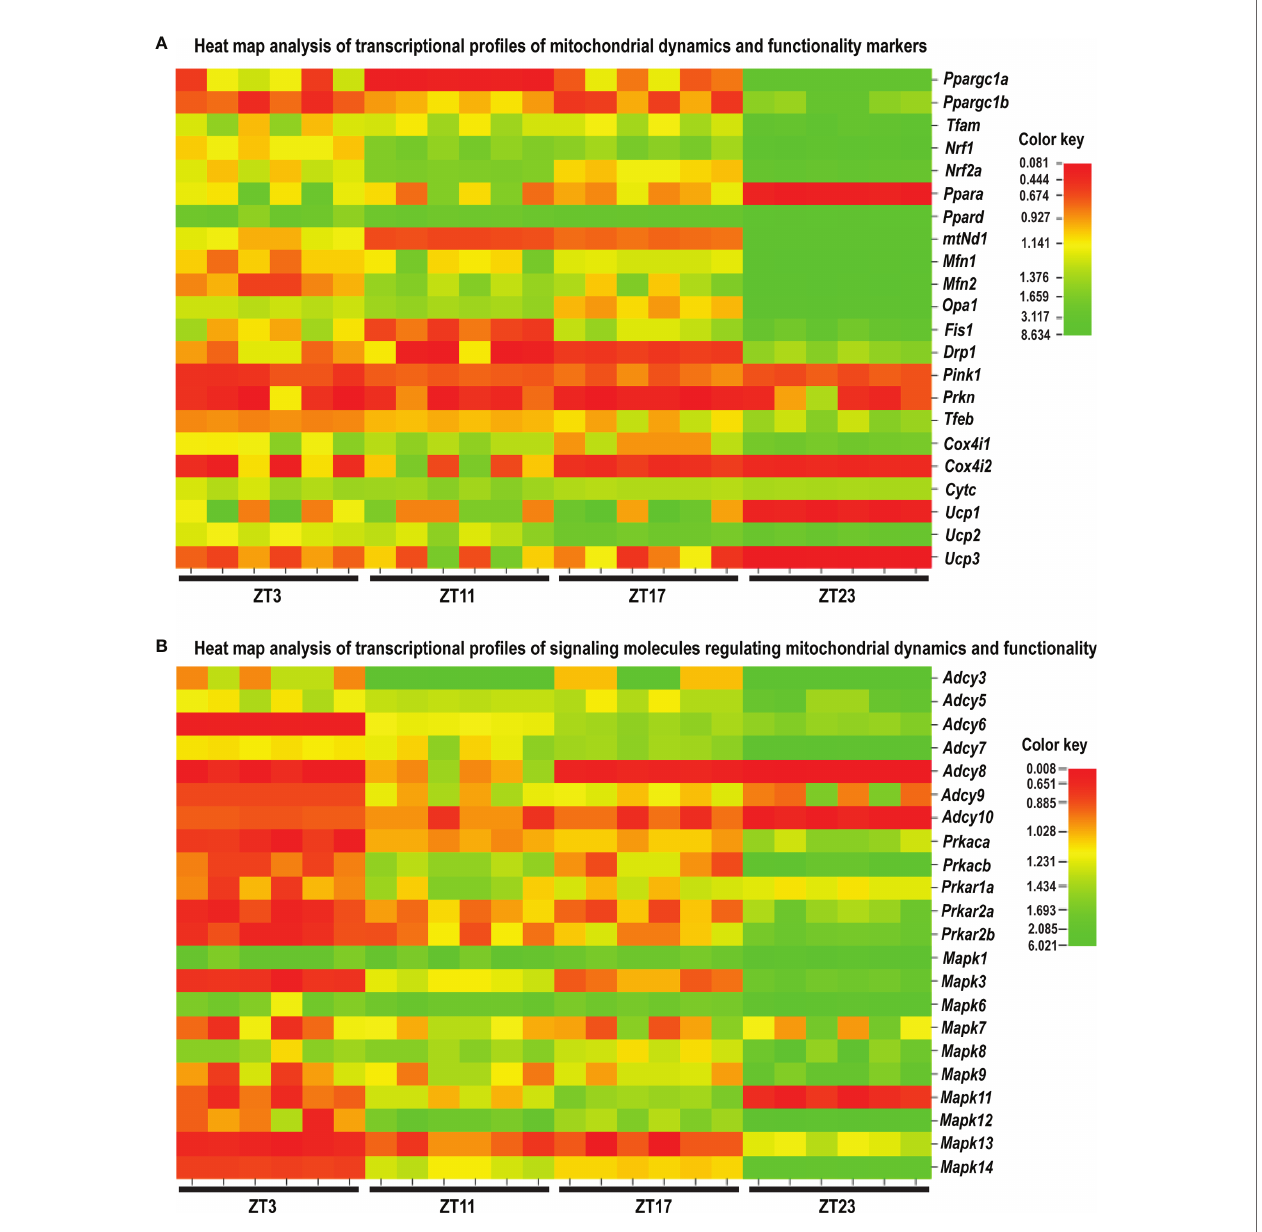
FIGURE 10 | Heat map analysis of the transcriptional pro fi le of the mitochondrial dynamic and functionality markers (A) and the signaling molecules regulating mitochondrial dynamics and functionality (B) in spermatozoa of acute stressed adult rats. Heat map analysis showing different patterns of transcription at different time points in spermatozoa after the acute immobilization stress. The relative fold change in gene expression for the aforementioned genes was compared in different time points (ZT3, ZT11, ZT17, and ZT23). Color from red to green indicates low to high